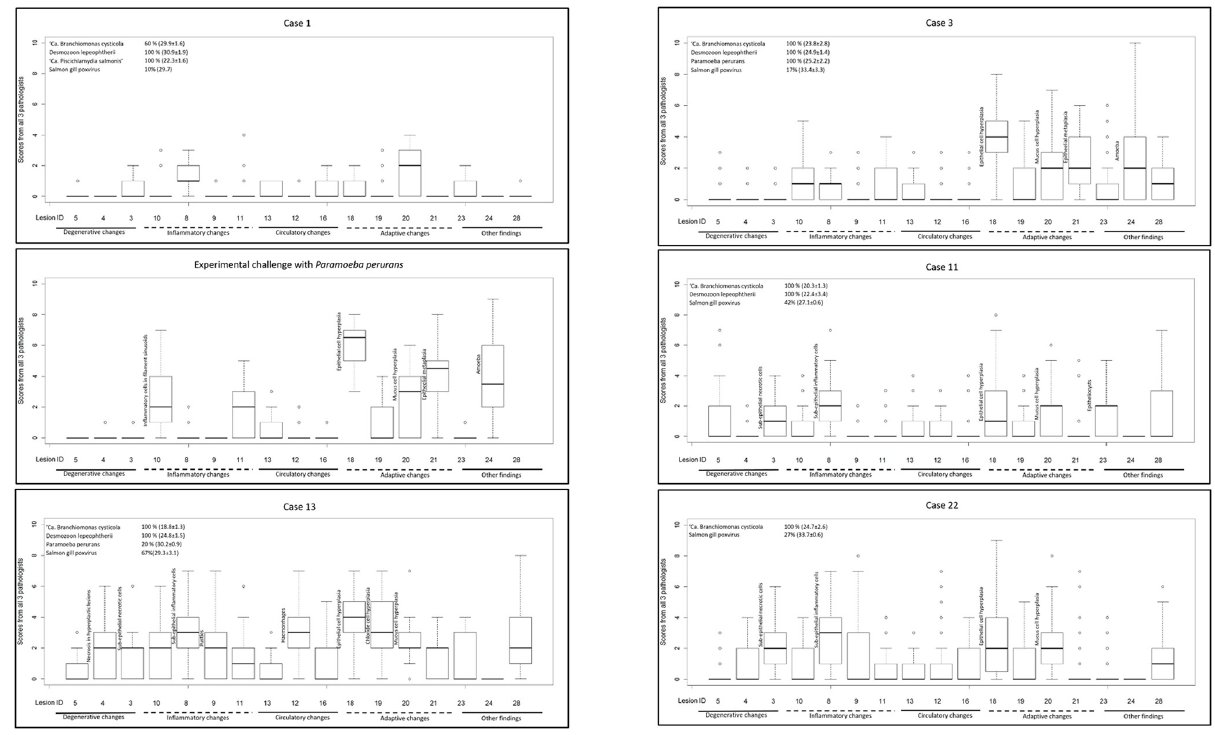
Fig 6. Presentation of the degree of histological lesions from the cases included in the scoring. Of the 28 lesions scored, 17 met the criteria for the Intra-class Correlation Coefficient analysis. The box in the left upper corner represents percentage positive fish for different microorganisms (median RT qPCR Ct-value for positives ± MAD). The lesion ID are explained in Table 2.